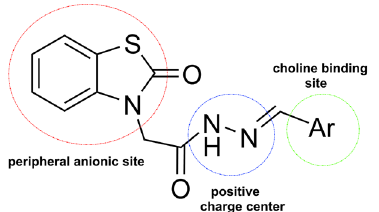
Figure 2. Structural hypothesis for the M